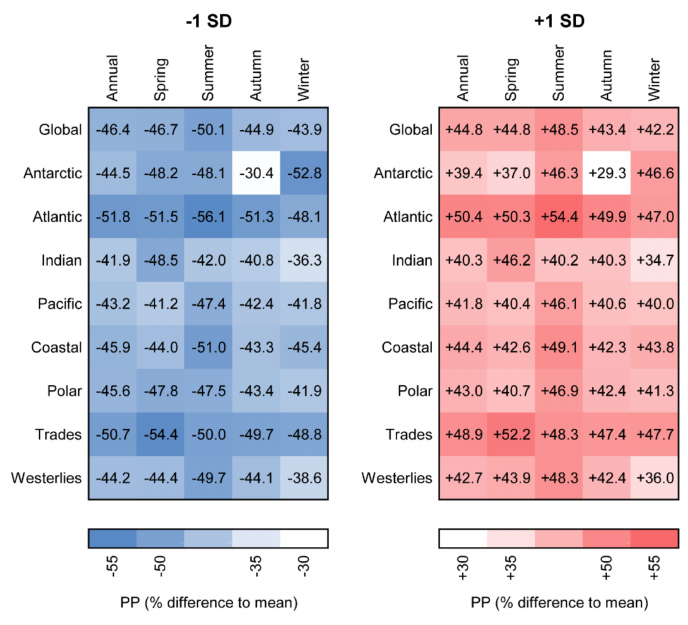
Figure 3. Percentage change in primary production (PP) for estimates based on mean photosynthesis versus irradiance (P-I) parameters ± 1 standard deviation compared with estimates based on mean P-I parameters. Mean percentage differences in annual and seasonal primary production for each ocean basin and biome are given. Data were obtained from model computations in which both P-I parameters were adjusted simultaneously and the light adaptation parameter (Ik) was unchanged.